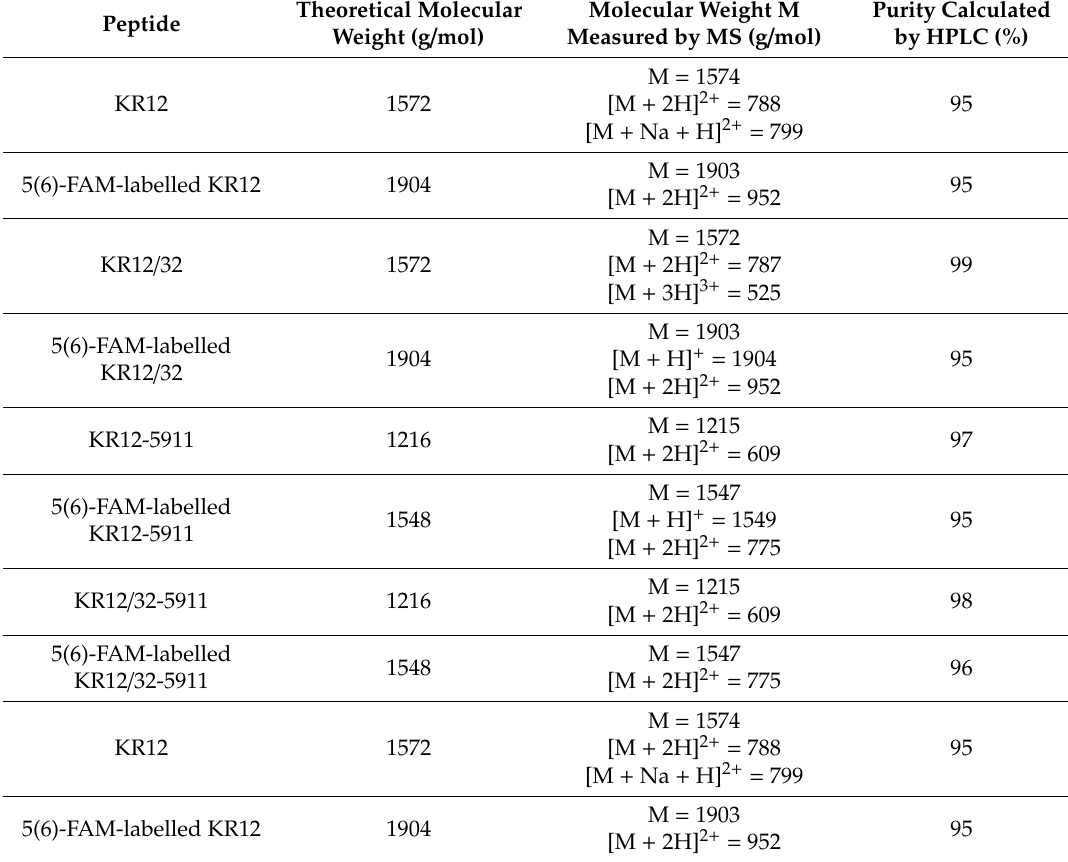
Table 2. Purity and mass analysis of